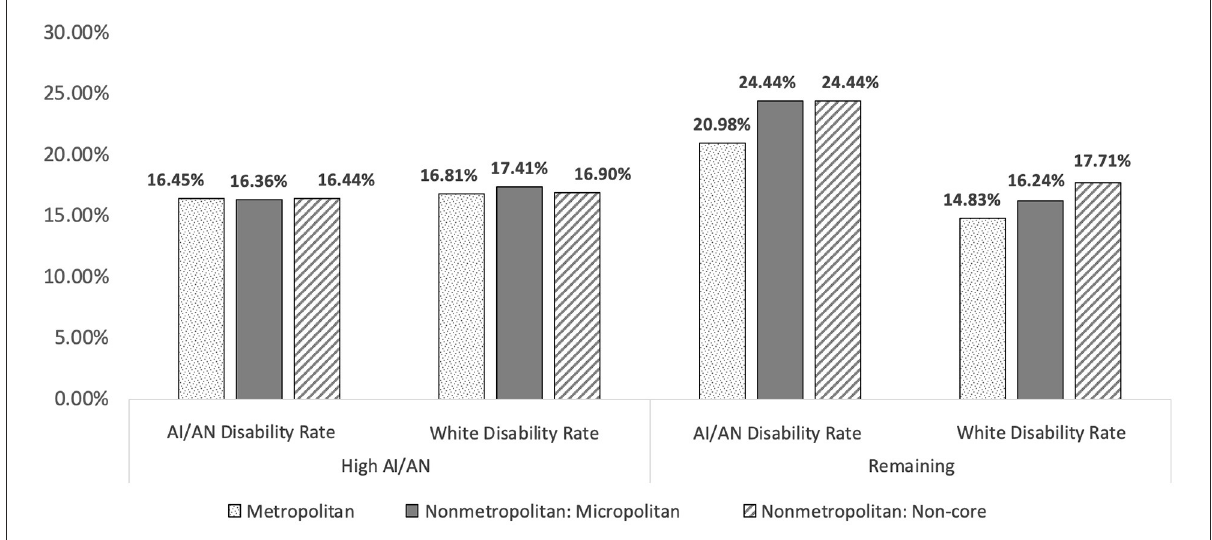
FIGURE3 Comparisons of county makeup, county classification, and AI/AN disability